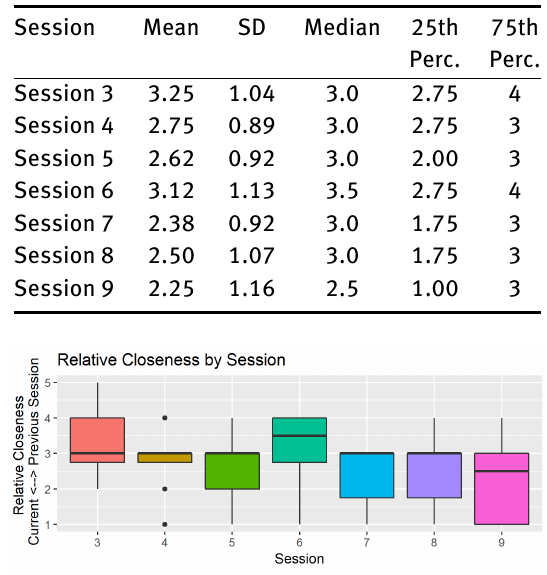
Figure 8: Responses to Global Evaluation measures across sessions for Robot for Others.